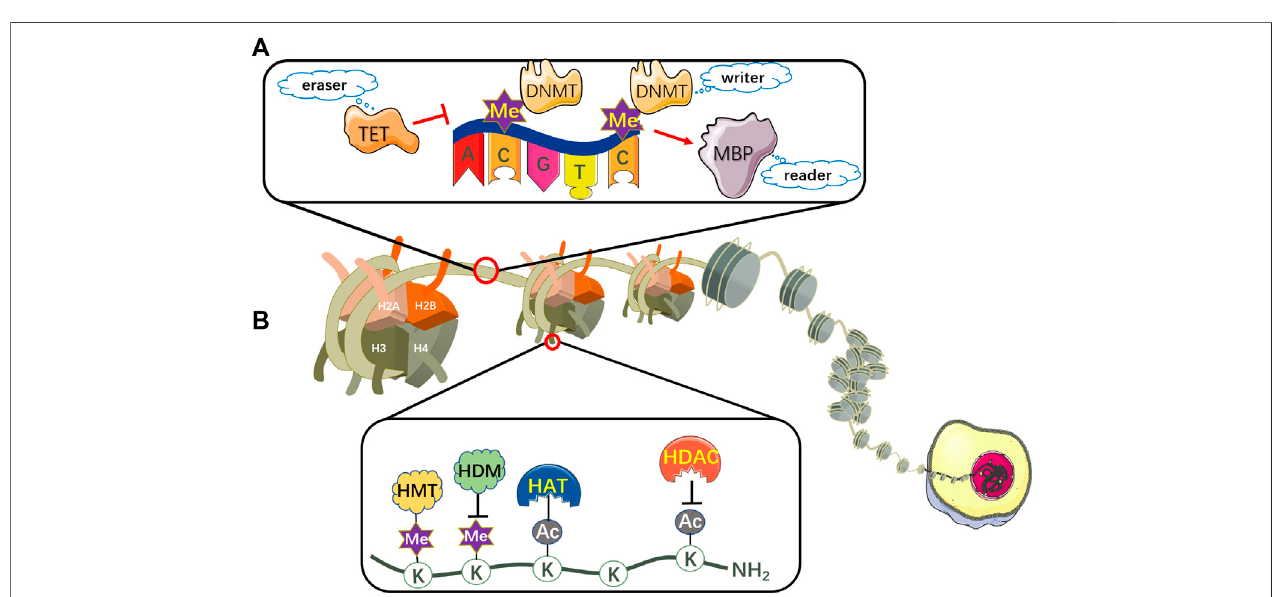
FIGURE 2 | The mechanism of DNA methylation and histone modi fi cations. (A) DNA can be epigenetically modi fi ed by DNMT-based methylation. DNMTs are involved in catalyzing a methyl group to CpG dinucleotides, thus representing writers in epigenetic modi fi cations. MBPs serve as readers to recognize and bind to the methylatedCpGsites.TETproteinsfunctionaseraserstoremovetheepigeneticlabelof5mC. (B) Nucleosomescompriseeighthistoneproteinsincludingtwocopiesof H2A,H2B,H3andH4.HistoneacetylationismaintainedbythecoordinationofHATsandHDACs,whichacetylateordeacetylate thelysineresiduesrespectivelyin the N-terminal tails of histones protruding from the octamer. Histone lysine methylation is regulated by HMTs and HDMs, which transfer or remove highly processive methyl addition to the lysine. TET, ten-eleven translocation; DNMT, DNA methyltransferase; MBP, methyl-CpG binding protein; Me, methyl group; HAT, histone acetyltransferase; HDAC, histone deacetylase; HMT, histone methyltransferase; HDM, histone demethylase; K, lysine residue; AC, acetyl group.